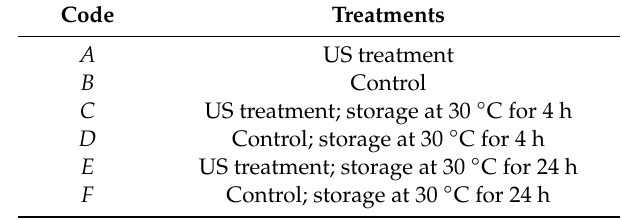
Table 2. Sample codes; experiment on thermal abuse.